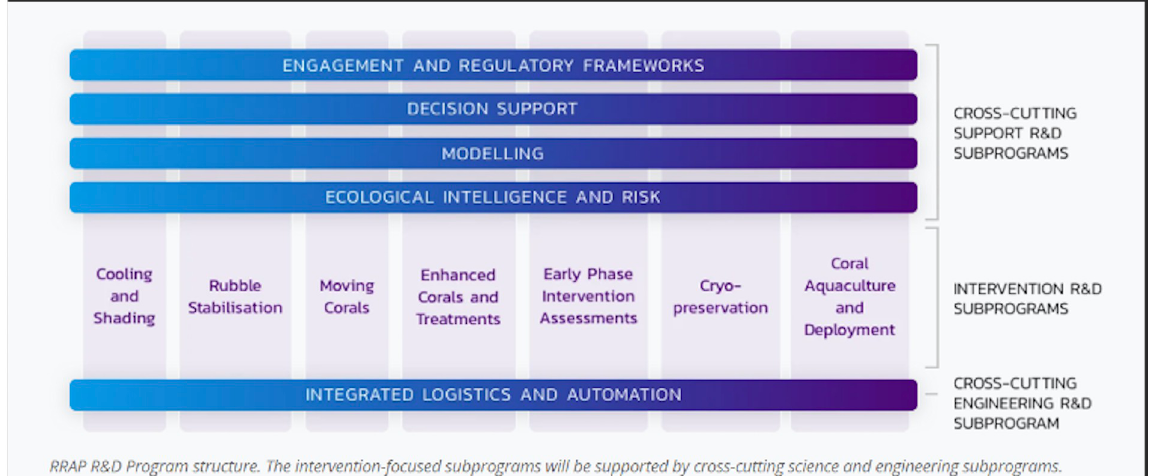
Fig 5. The core of the RRAP Program is founded on seven intervention research and development subprograms, including: (1) cooling and shading, (2) rubble stabilisation, (3) moving corals (larval-based restoration), (4) enhanced corals and treatments, (5) early phase intervention assessments, (6) cryopreservation, and (7) coral aquaculture and deployment. These are supported by crosscutting R&D subprograms, engagement and regulatory frameworks, decision support, modelling, and ecological intelligence and integrated logistics and